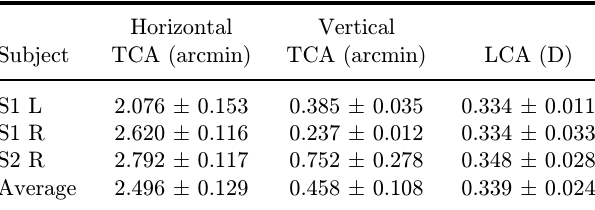
Table 4. Chromatic aberrations between red (639.1 nm) and near-infrared (786 nm) lights in the central ¯eld of